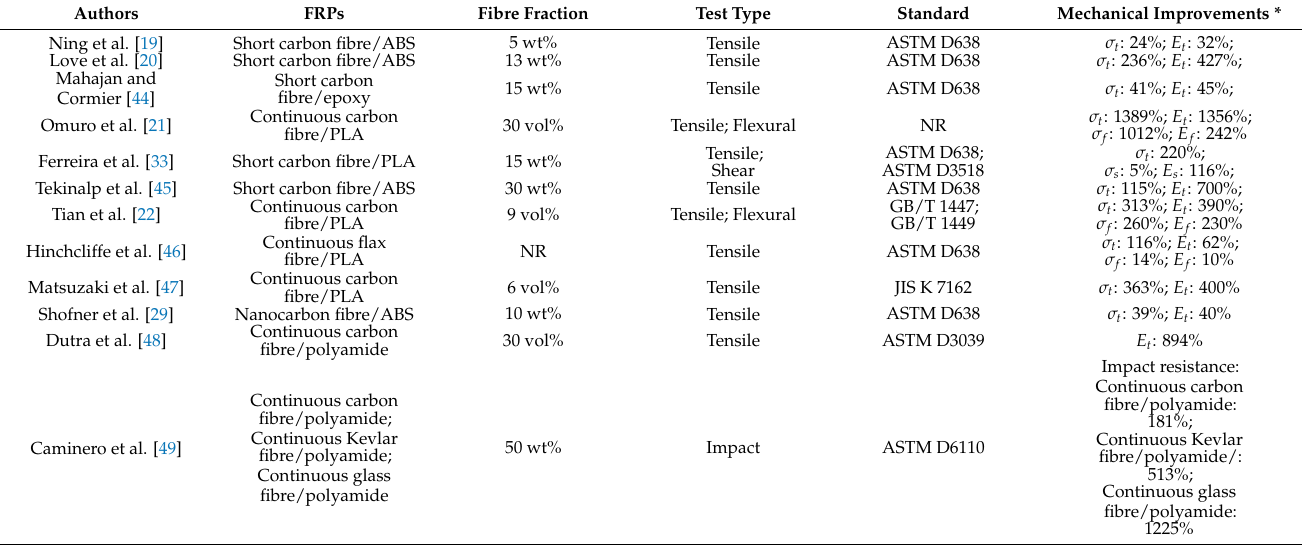
Table 2. The mechanical improvement of fibre-reinforced polymer manufactured via